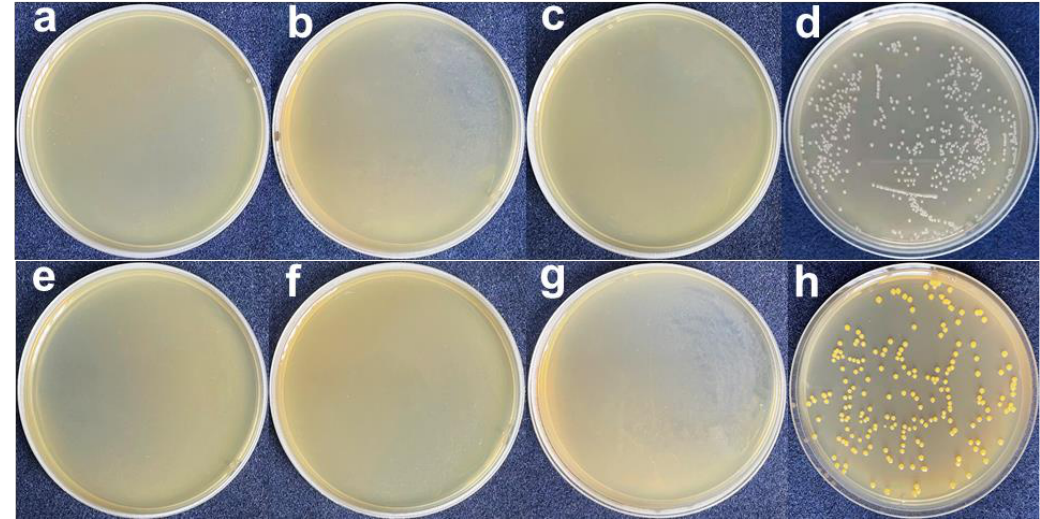
Figure 4. The picture of antibacterial powder to treat colony growth in E. coli and S. aureus ( a,e ) Table 1. Antibacterial rate of antibacterial powder against E. coli and S. aureus . Sample Serial Number